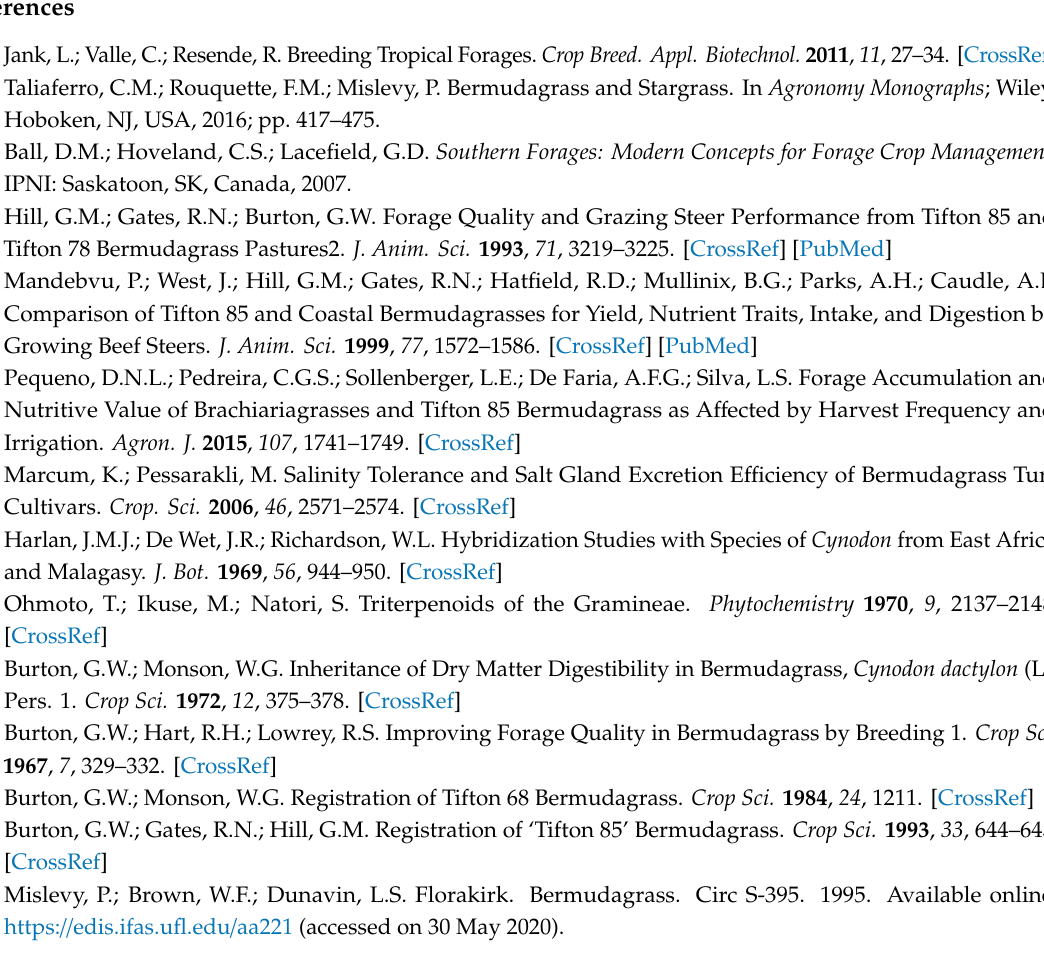
Table S1: Predicted genetic values estimated of nutritive value traits: crude protein (CP), phosphorous (P), in vitro digestible organic matter (IVDOM) and nutrient detergent fiber (NDF) in g.kg − 1 , for the USDA-NPGS bermudagrass germplasm collection evaluated in Citra,